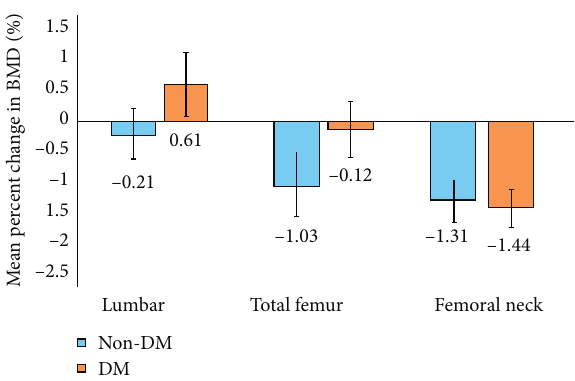
Figure 2: Mean percent change in bone mineral density from baseline after epidural steroid injections. Values are presented as mean ± SD. There were no significant differences between baseline and posttreatment BMD values. The values below bar graphs represent the mean percent change in BMD. The non-DM group consisted of postmenopausal women without diabetes mellitus who received ESI. The DM group consisted of postmenopausal women with diabetes mellitus who received ESI. Bone mineral density data are based on T -scores. BMD � bone mineral density; ESI � epidural steroid injection.